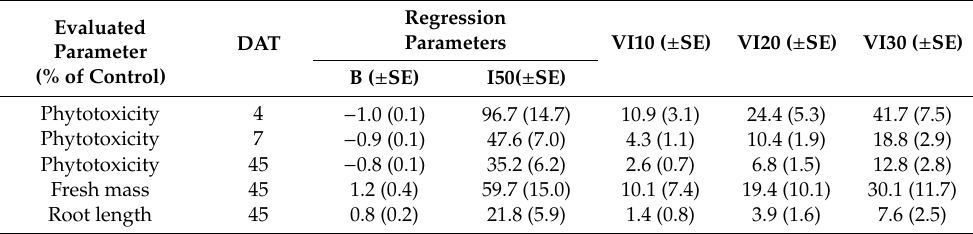
Table 1. Glyphosate doses g ha − 1 that resulted in 10% (VI10), 20% (VI20) and 30%, (VI30) for responses in soybean in the measured parameters (% of control).